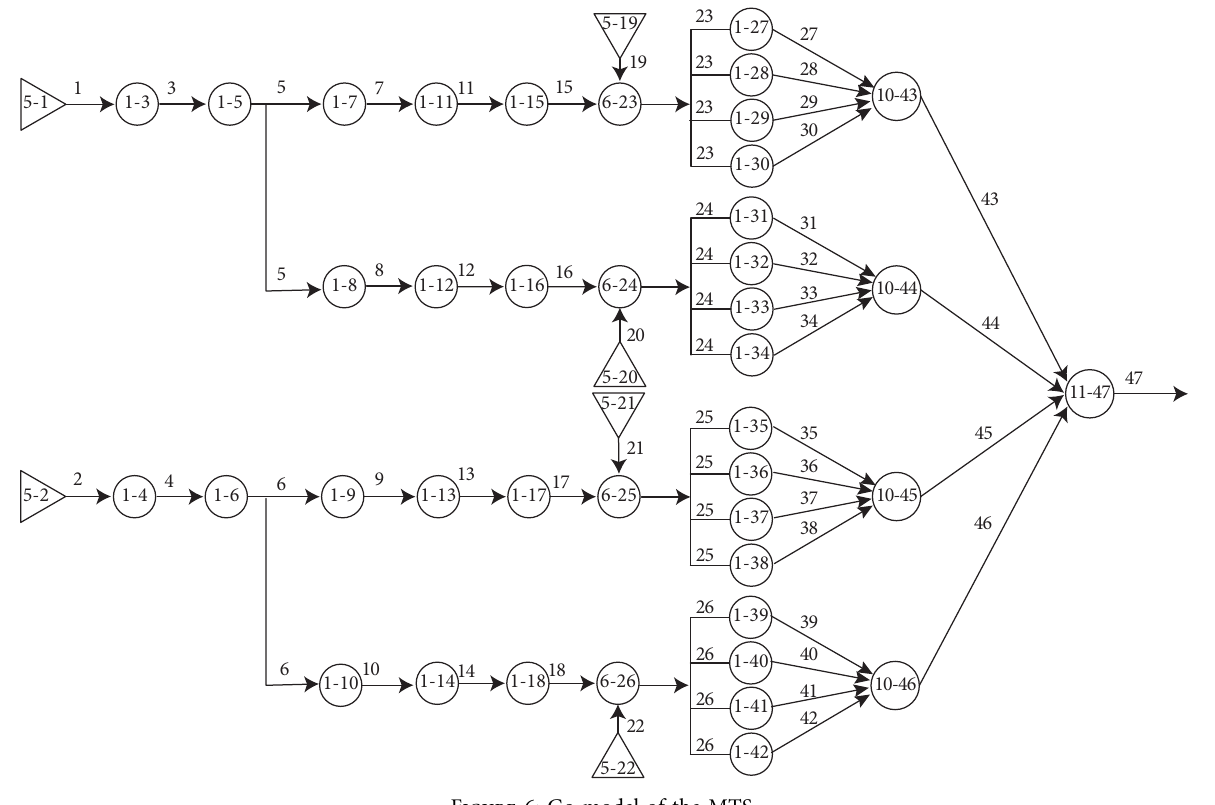
Figure 6: Go model of the MTS.